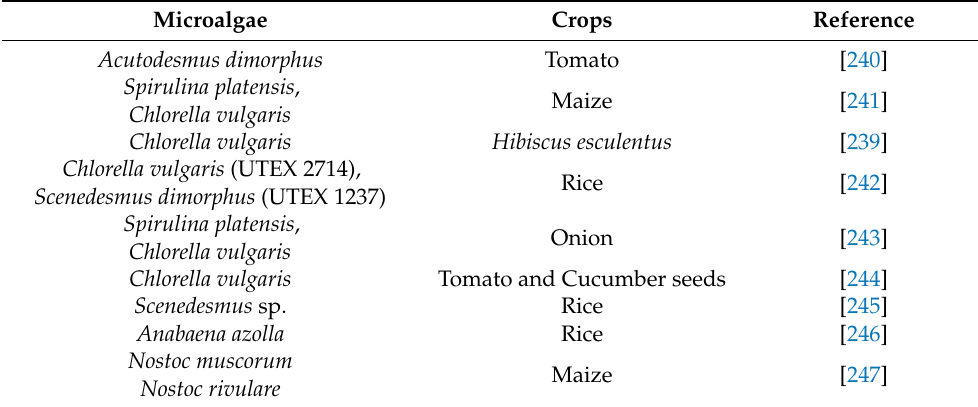
Table 7. Microalgae species and their use as plant biofertiliser and